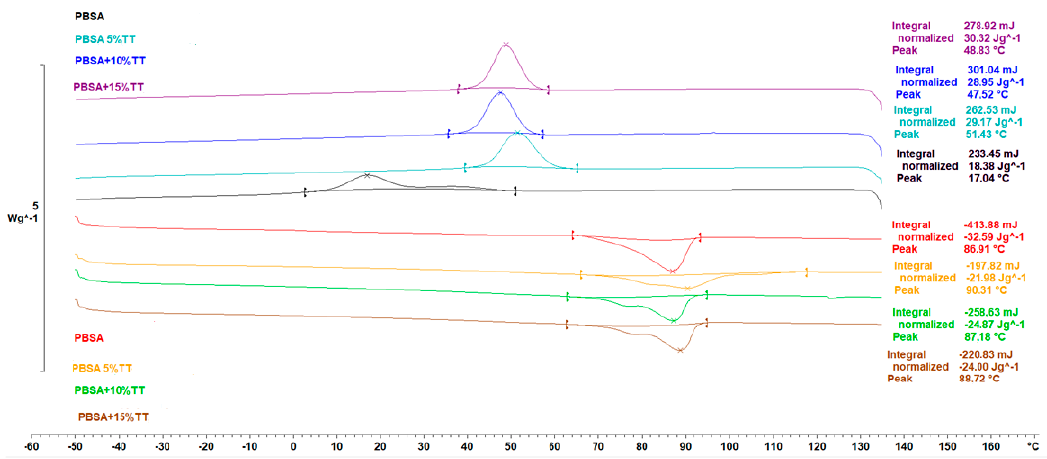
Figure 6. DSC thermograms of PBSA-based biomaterials. Table 4. Thermal properties of pure PBSA and its composites.